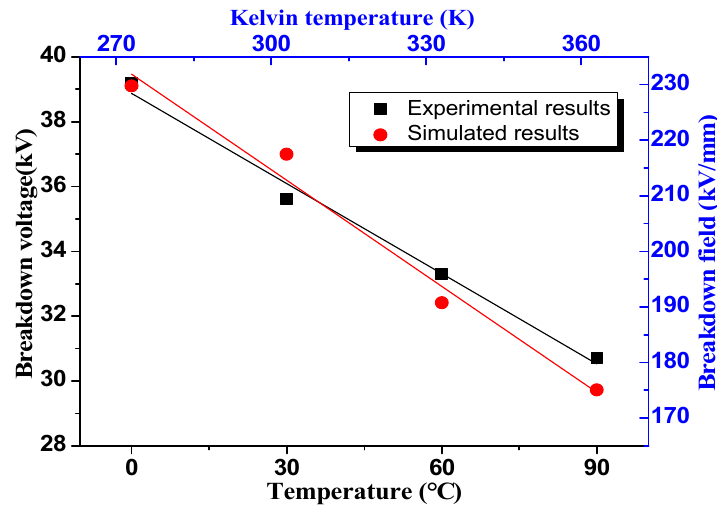
Figure 8. Comparison of electro ‐ thermal breakdown simulations and breakdown experiments. Temperature ‐ and electric field ‐ dependent mobility was considered, and so was negative differential mobility.